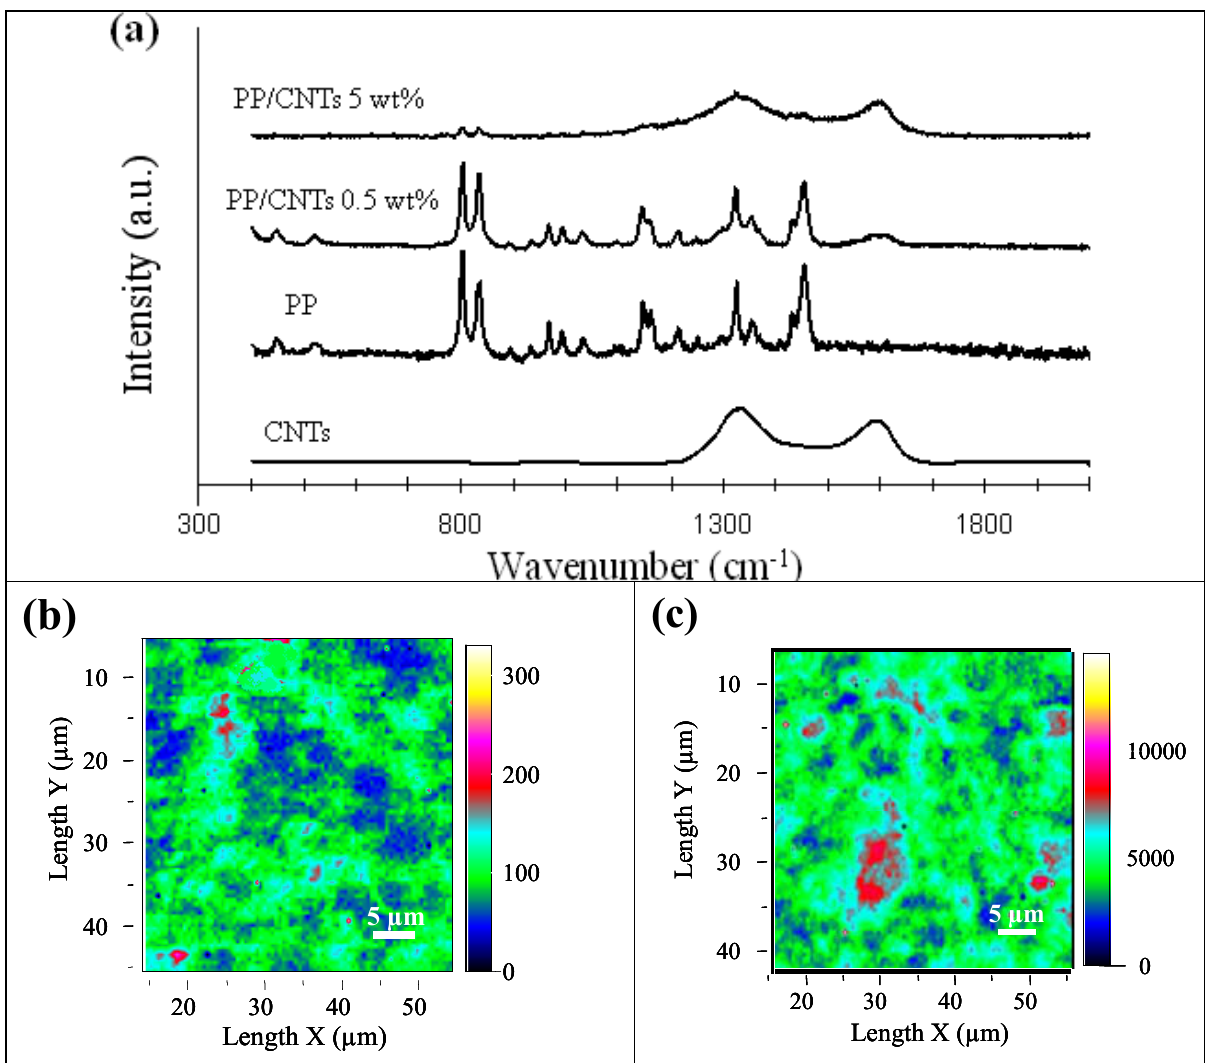
Figure 4. (a) Raman spectra of CNTs, neat iPP, and composites at 0.5 and 5 wt %